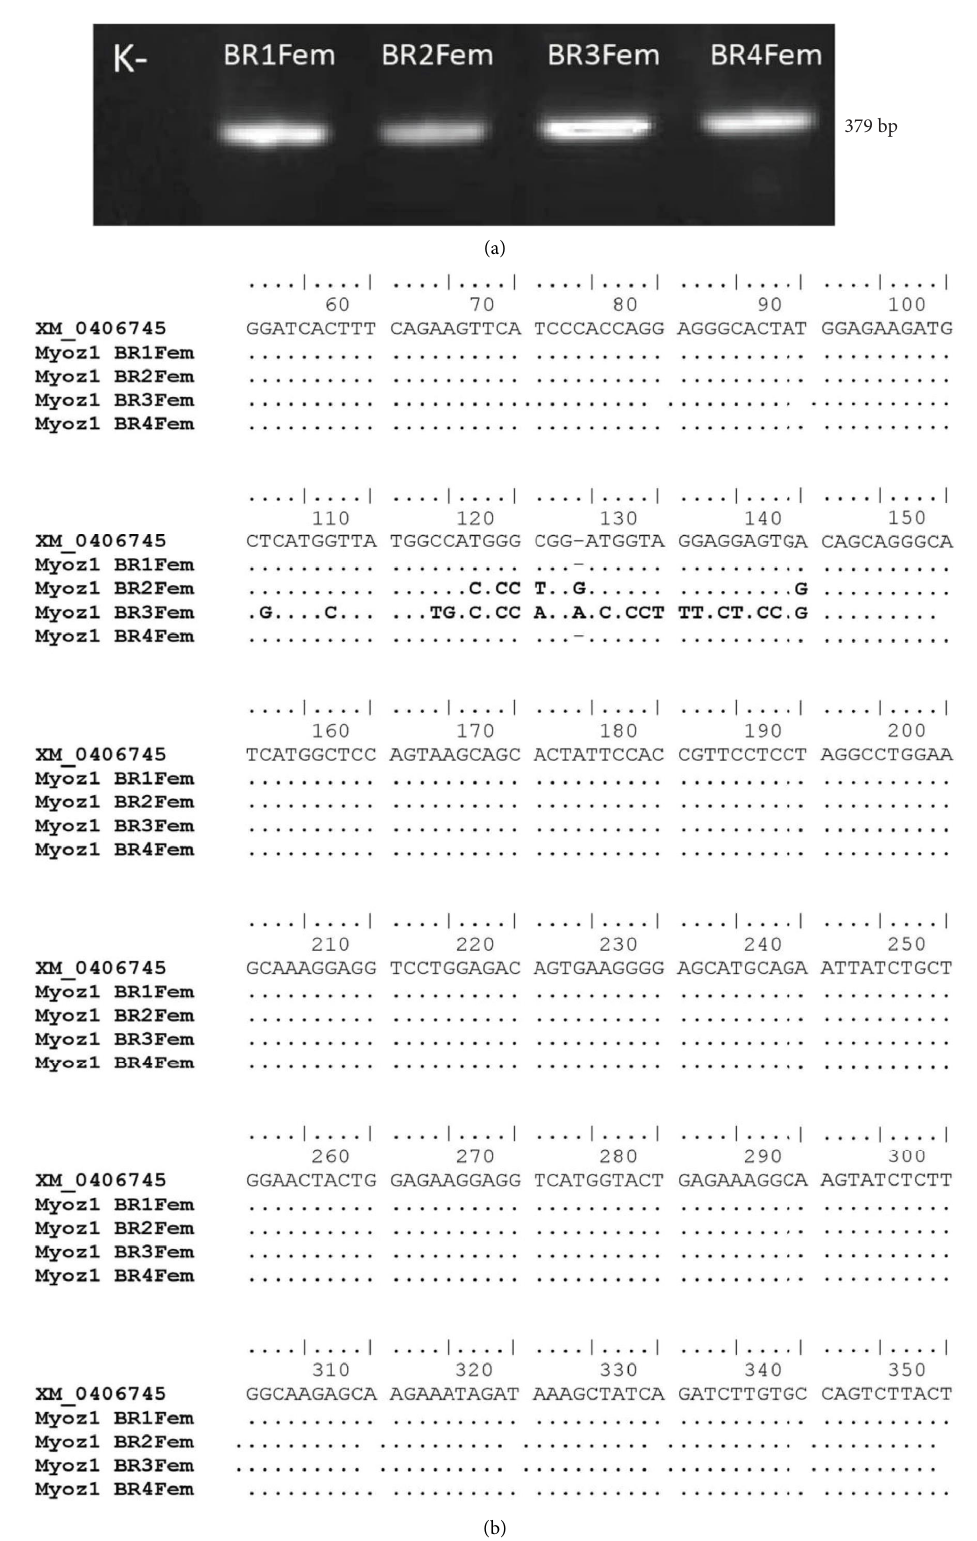
Figure 1: Te profle of Myoz1 gene expression of broiler chicken femur from four diferent locations. (a) Te amplicon of Myoz1 gene in 1.5% agarose gel. (b) Alignment of exon 3 of Myoz1 gene from the GenBank (XM_0406745) and broiler chicken from four locations (BR1Fem from district 1; BR2Fem from district 2; BR3Fem from district 3; and BR4Fem from district